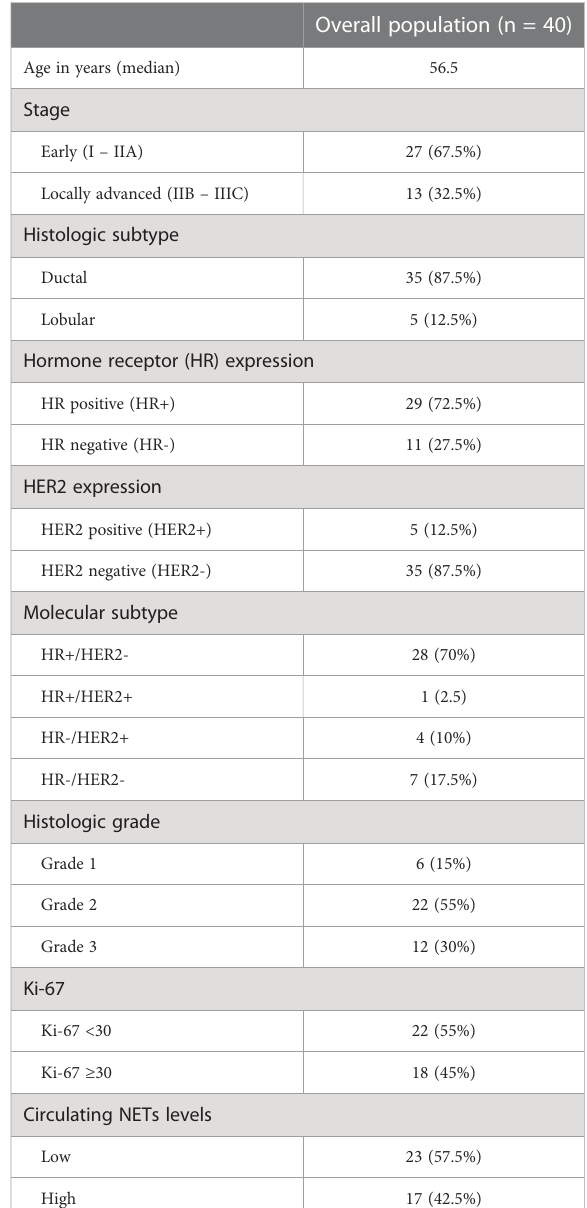
TABLE 1 Patients ’